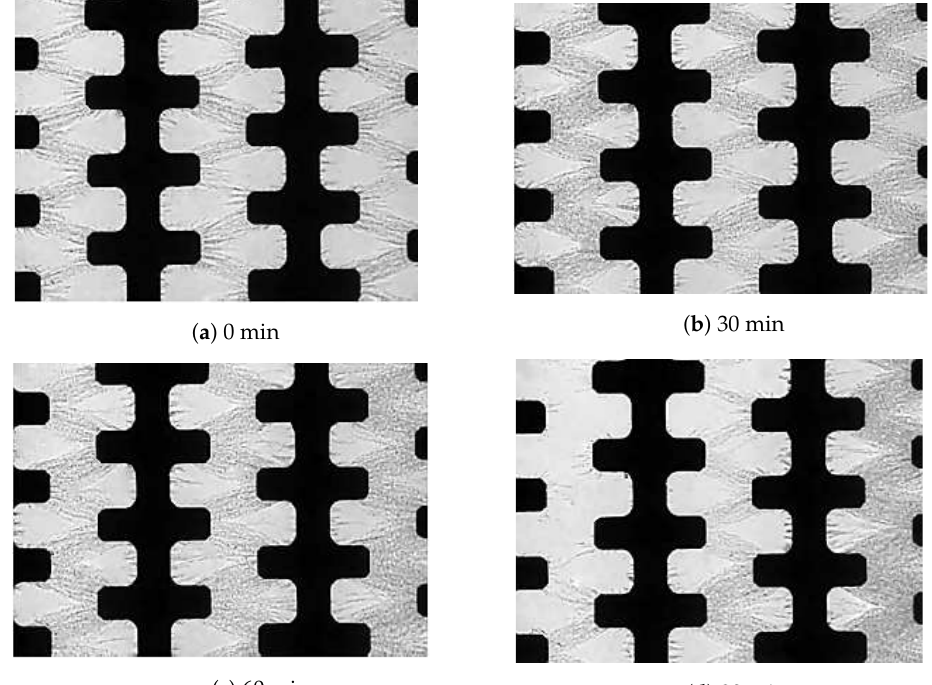
Figure 5. After 90 min of separation time, the E. coli concentration reduced significantly from the microelectrodes array 500 at a low conductivity σ m of 40µS/cm, pulsing time of 12 s and a high fluid flow of 9.6 µ L min − 1 . The flow direction was from left to